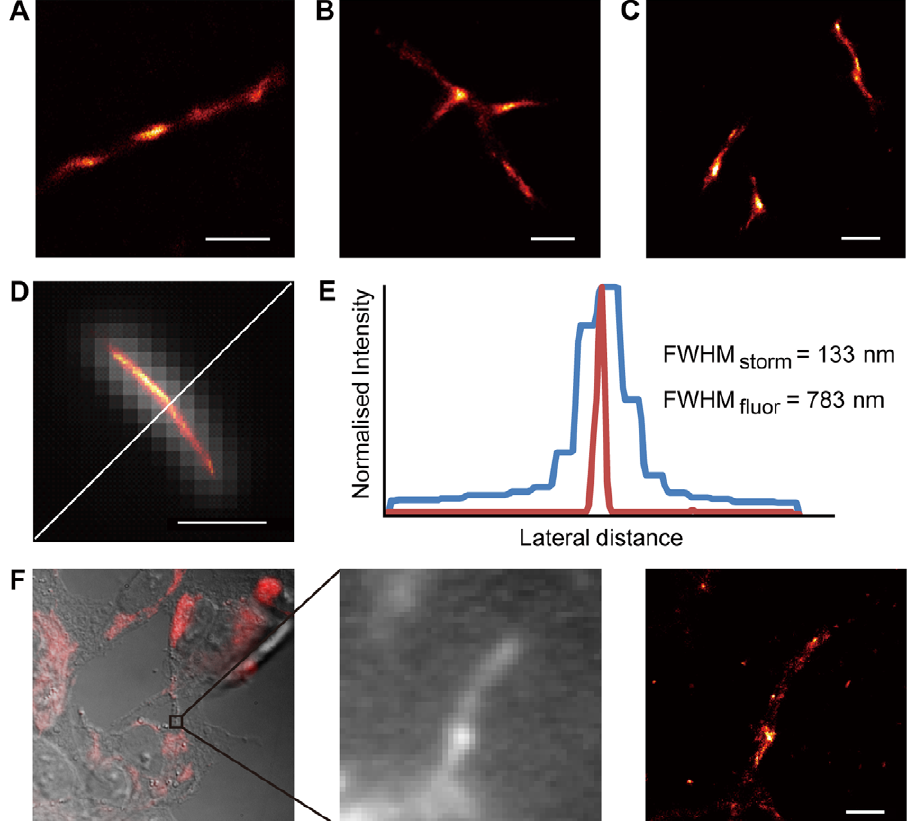
Figure 4. d STORM images of BioHuL fibrils. (A)–(C) Super-resolution d STORM images of different BioHuL fibrils (formed in vitro ). (D) An overlay of a straight BioHuL fibril with its fluorescence sum image. (E) The cross-sections of the individual fluorescence sum and the super-resolved d STORM image of the BioHuL fibril displayed in panel (D). The full-width half-maximum (FWHM) of the fluorescence intensity distribution of the unresolved sum image depicts a fibril diameter of 783 nm whereas the super-resolved image depicts a fibril diameter of 133 6 20 nm; the latter showing 6 times better resolution. (F) (left panel) DIC image of BioHuL present within SH-SY5Y mammalian cells after probing with streptavidin-Alexa647. (middle panel) Fluorescence sum image of a region within the SH-SY5Y cells (right panels) Super-resolution d STORM images of BioHuL fibrils in the same region of the SH-SY5Y mammalian cells as the fluorescence sum image. All scale bars all represent 1 m m.